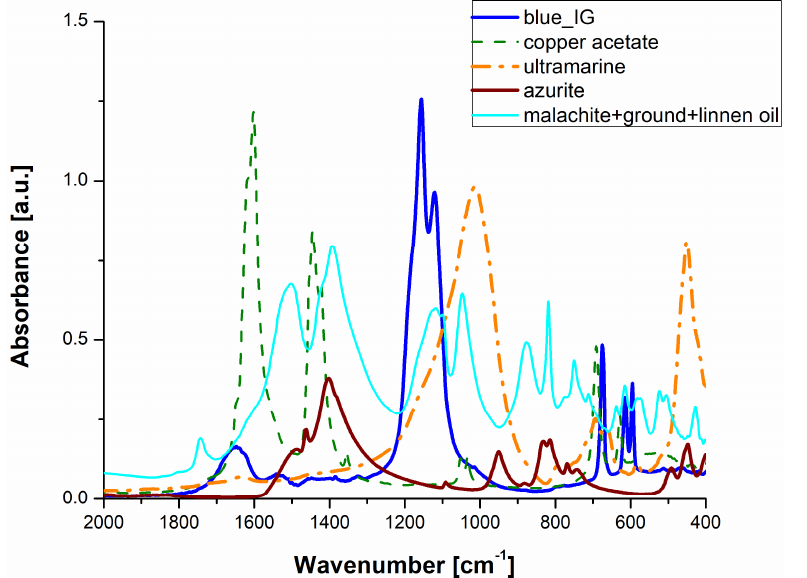
Figure 14. FTIR spectra of various blue and green painting materials, 2000 to 400 cm −1 spectral range, extended Oy axis.